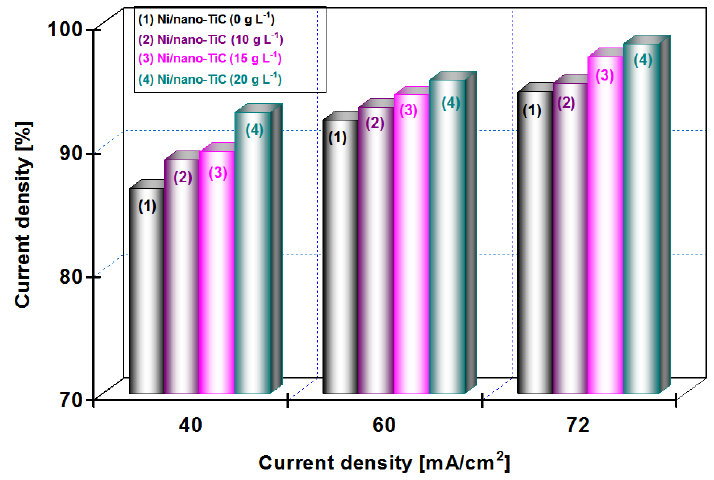
Figure 10. Current efficiency versus applied current densities at different concentrations of nano TiC particles added to nickel electrolyte at deposition time of 30 min.